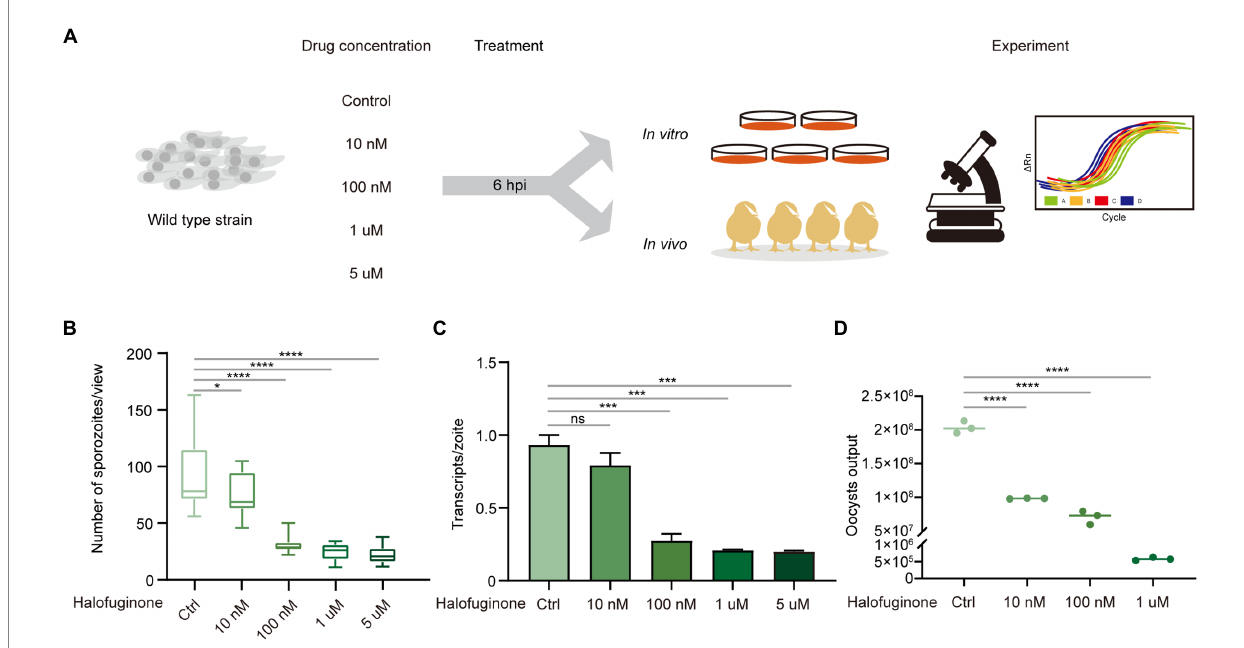
FIGURE 1 Halofuginone affects invasion and endogenous development in E. tenella . (A) Schematic illustration of the experimental design. The fresh sporozoites were extracted and treated with different concentrations (0, 10, 100 nM and 1, 5 μ M) of halofuginone for 6 h. Designed experiments to detect the difference between different groups in vivo and in vitro . (B) The effect of halofuginone on the invasion efficiency for E. tenella in MDBK cells. Sporozoites were counted at 25 different locations in each well under a microscope and each sample was performed with triplicates. *** p < 0.001. (C) Detection of changes in invasion by RT-qPCR when sporozoites are preincubated with different concentrations of halofuginone (0, 10, 100 nM and 1, 5 μ M). Values represent the mean ± SEM from five independent experiments performed in triplicates. *** p < 0.001. (D) Comparison of the number of oocysts output among different concentrations (0, 10, 100 nM and 1 μ M). Each sample was performed twice. *** p <